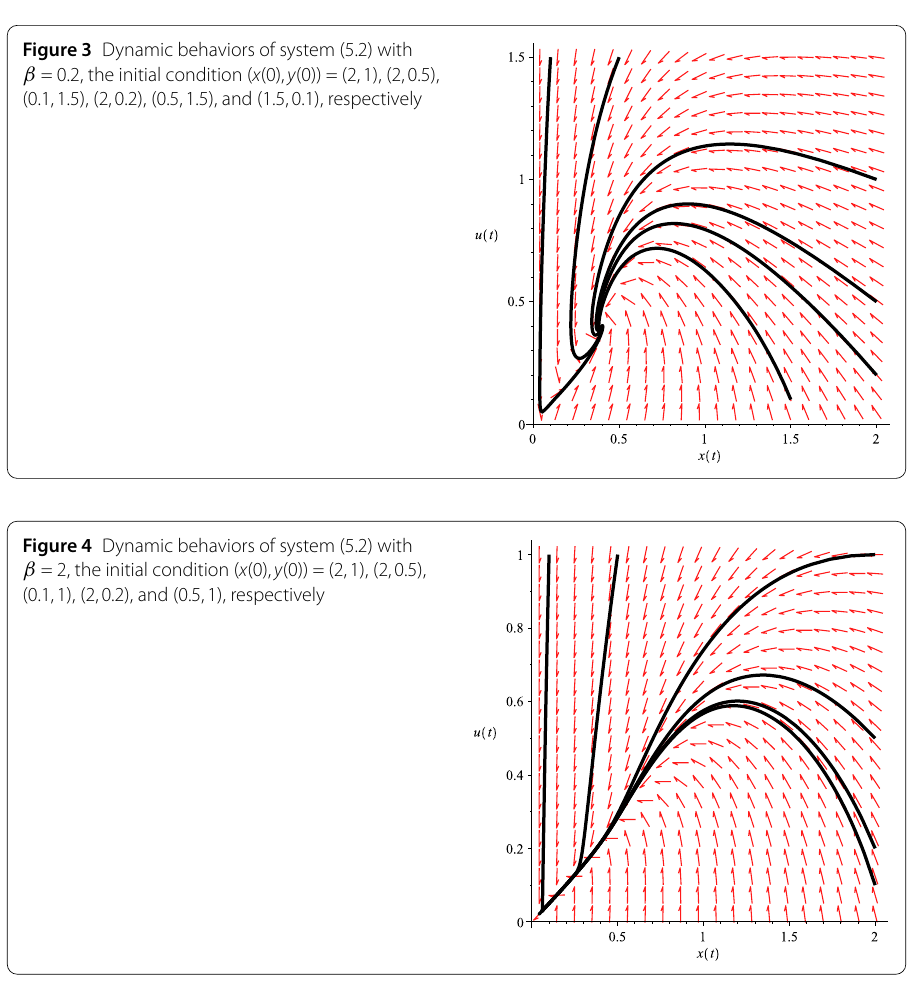
Figure 3 Dynamic behaviors of system (5.2) with β = 0.2, the initial condition ( x (0), y (0)) = (2,1), (2,0.5), (0.1,1.5), (2,0.2), (0.5,1.5), and (1.5,0.1), respectively